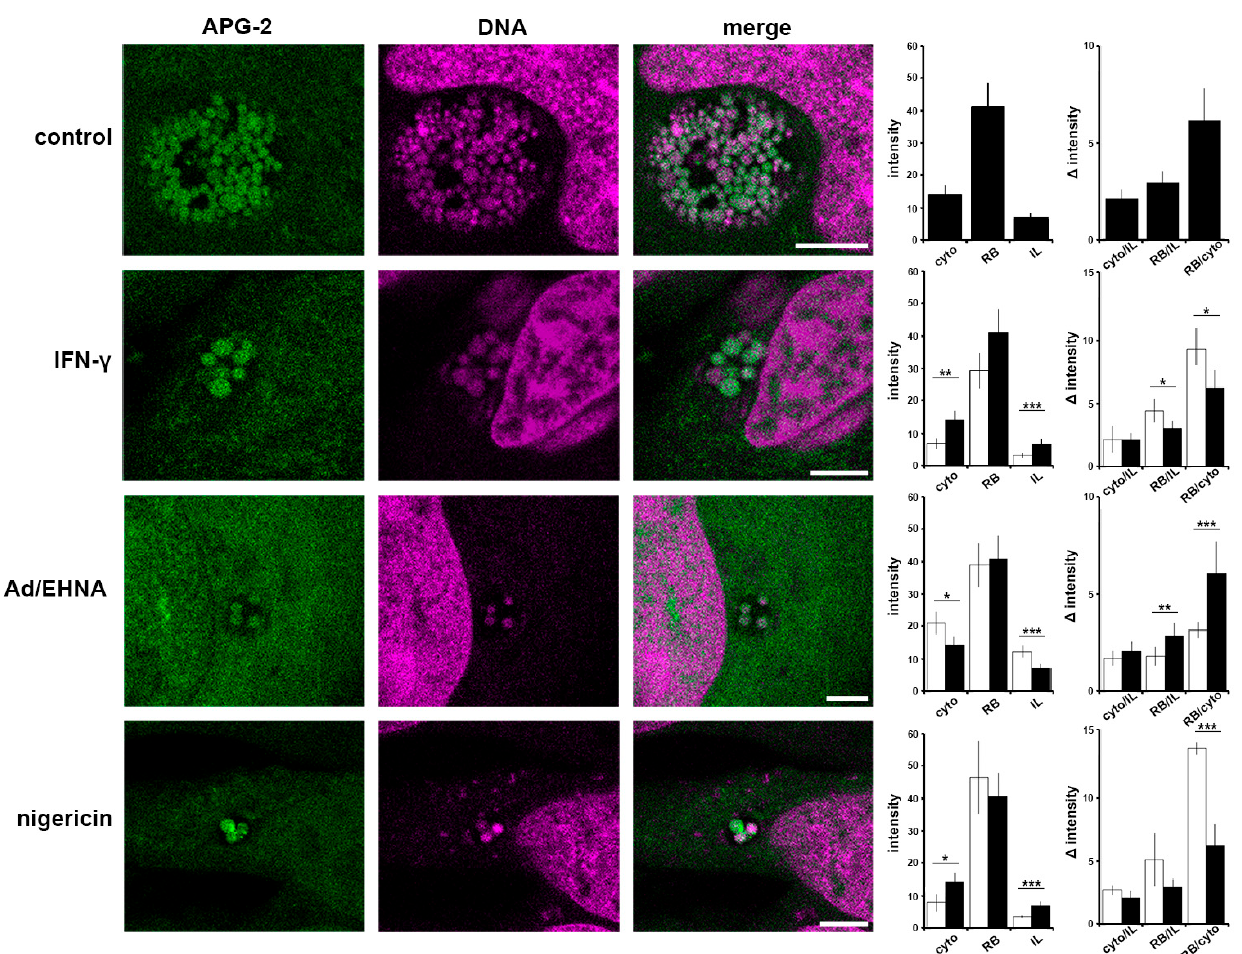
Figure 5. Critical importance of the interface between the bacteria and host cytosol. HeLa cells were infected with C. trachomatis LGV2. At 12 hpi cells were treated IFN- γ , Ad/EHNA (adenosine) or nigericin and incubated for a further 12 h. At 24 hpi, cells were incubated with APG-2 and DNA probe (DRAQ-5, magenta) and imaged using confocal microscopy ( left panels ). Scale bars: 5 µm. Image analyses allowed the comparison of the average APG-2 intensity in the cytoplasm (cyto), reticulate bodies (RB) and inclusion lumen (IL), and a ratio determined ( right panels ). Black column: non-treated, white column: treated. Error bars: standard deviation. * p < 0.05, ** p < 0.01, *** p < 0.005.